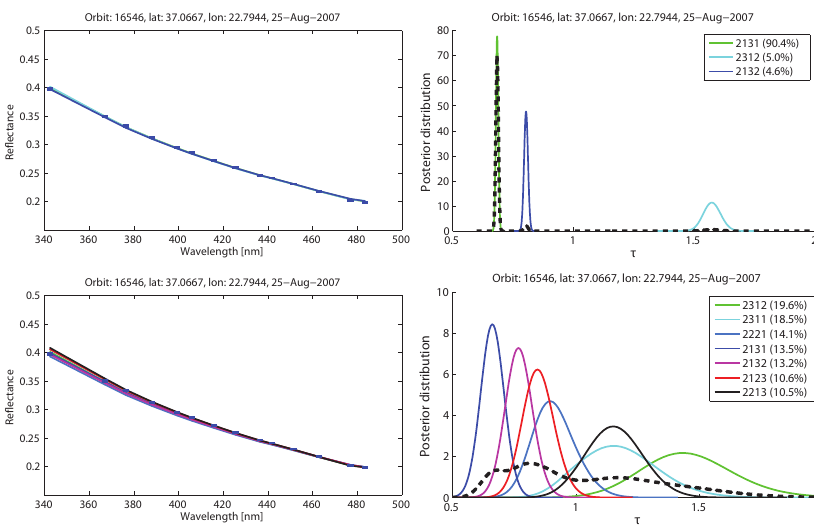
Fig. 6. Greece, 25 August 2007. Upper row: the best three models when the model discrepancy is not included. Bottom row: the best seven models when the model discrepancy is included. See Fig. 5 for more explanation.